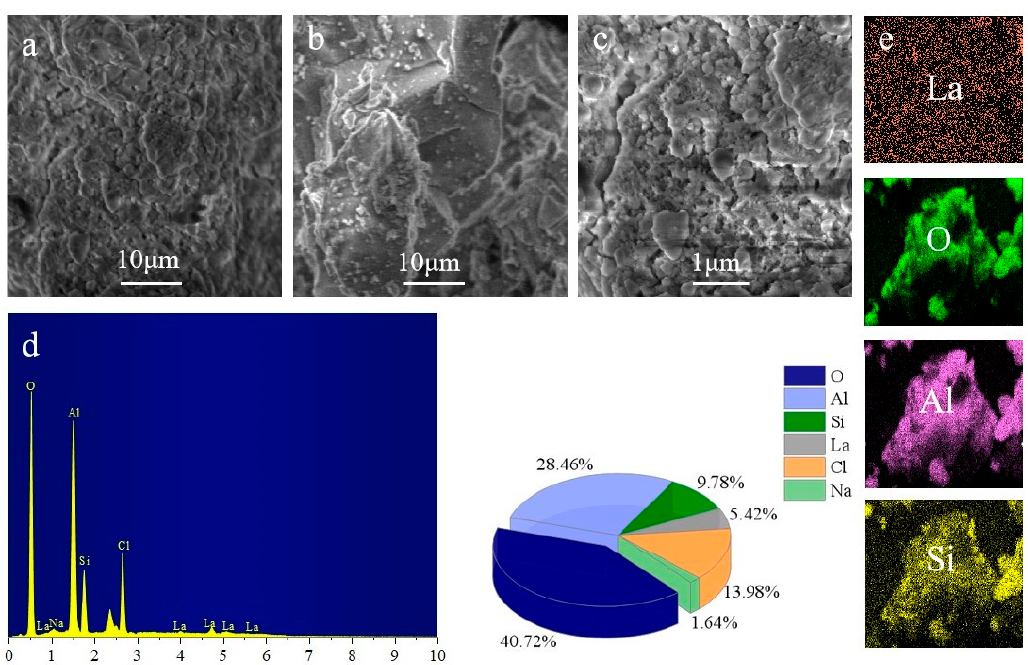
Figure 4. SEM photographs of PALS at low magnification ( a ), PASiC at low magnification ( b ), and PALS at high magnification ( c ); EDS spectrum of PALS ( d ); and mappings of PALS ( e ).